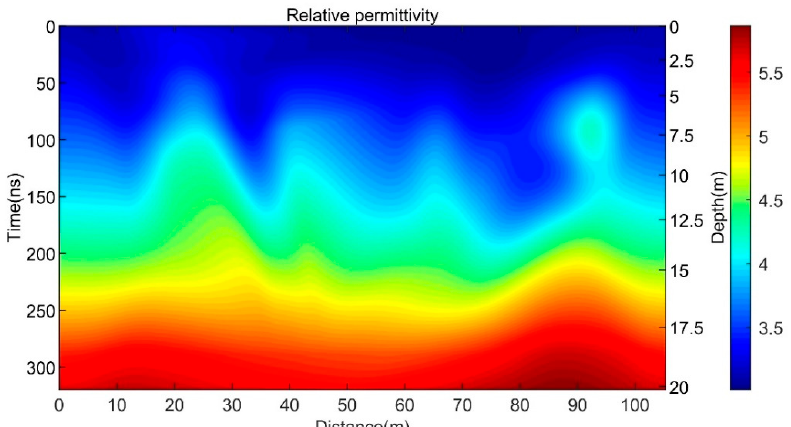
Figure 12. The subsurface relative permittivity structure.